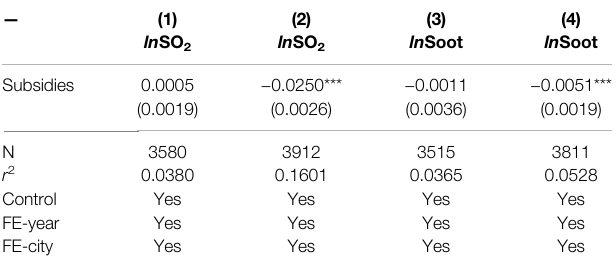
TABLE 5 | Heterogeneity of enforcement of environmental regulations.